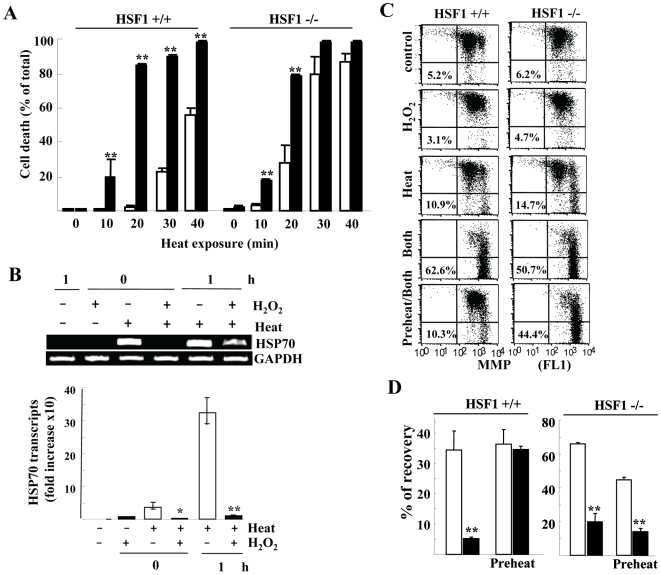
Effect of H2O2 on heat-exposed HSF +/+ and -/- MEFs.
A) Cell death at 24 h after heat exposure (42.5°c for the indicated min) with (closed) or without (open bars) 0.5 mM H2O2 pretreatment. B) HSP70 transcripts evaluated by RT-PCR transcription at the indicated hours after the indicated treatments (upper) were determined by real-time PCR with normalization to GAPDH levels (lower panel). C) Preconditioning effect on disruption of Δψm. Both MEF cells were treated as indicated, heat (Heat; 42.5°c for 20 min), 0.5 mM H2O2 treatment (H2O2) and both treatments (Both). As thermal preconditioning, cells were preheated (40.5°c for 30 min 10 h) prior to both treatments (Preheat/Both). Cells were cultured for 20 h after heat exposure and incubated with DePsipher solution. Numbers indicate % of cells showing loss of Δψm. D) Effect of H2O2 pretreatment on refolding activity. Refolding activity was evaluated by recovery of luciferase activity 5 h after heat exposure (42.5°c for 20 min) with (closed) or without (open bars) 0.5 mM H2O2 pretreatment. Cells were also treated by thermal preconditioning (Preheat) as described in C. In A, B and D, columns display the mean ± S.D. of data from three separate experiments and *, P<0.05; **, P<0.01 compared with H2O2-untreated cells.